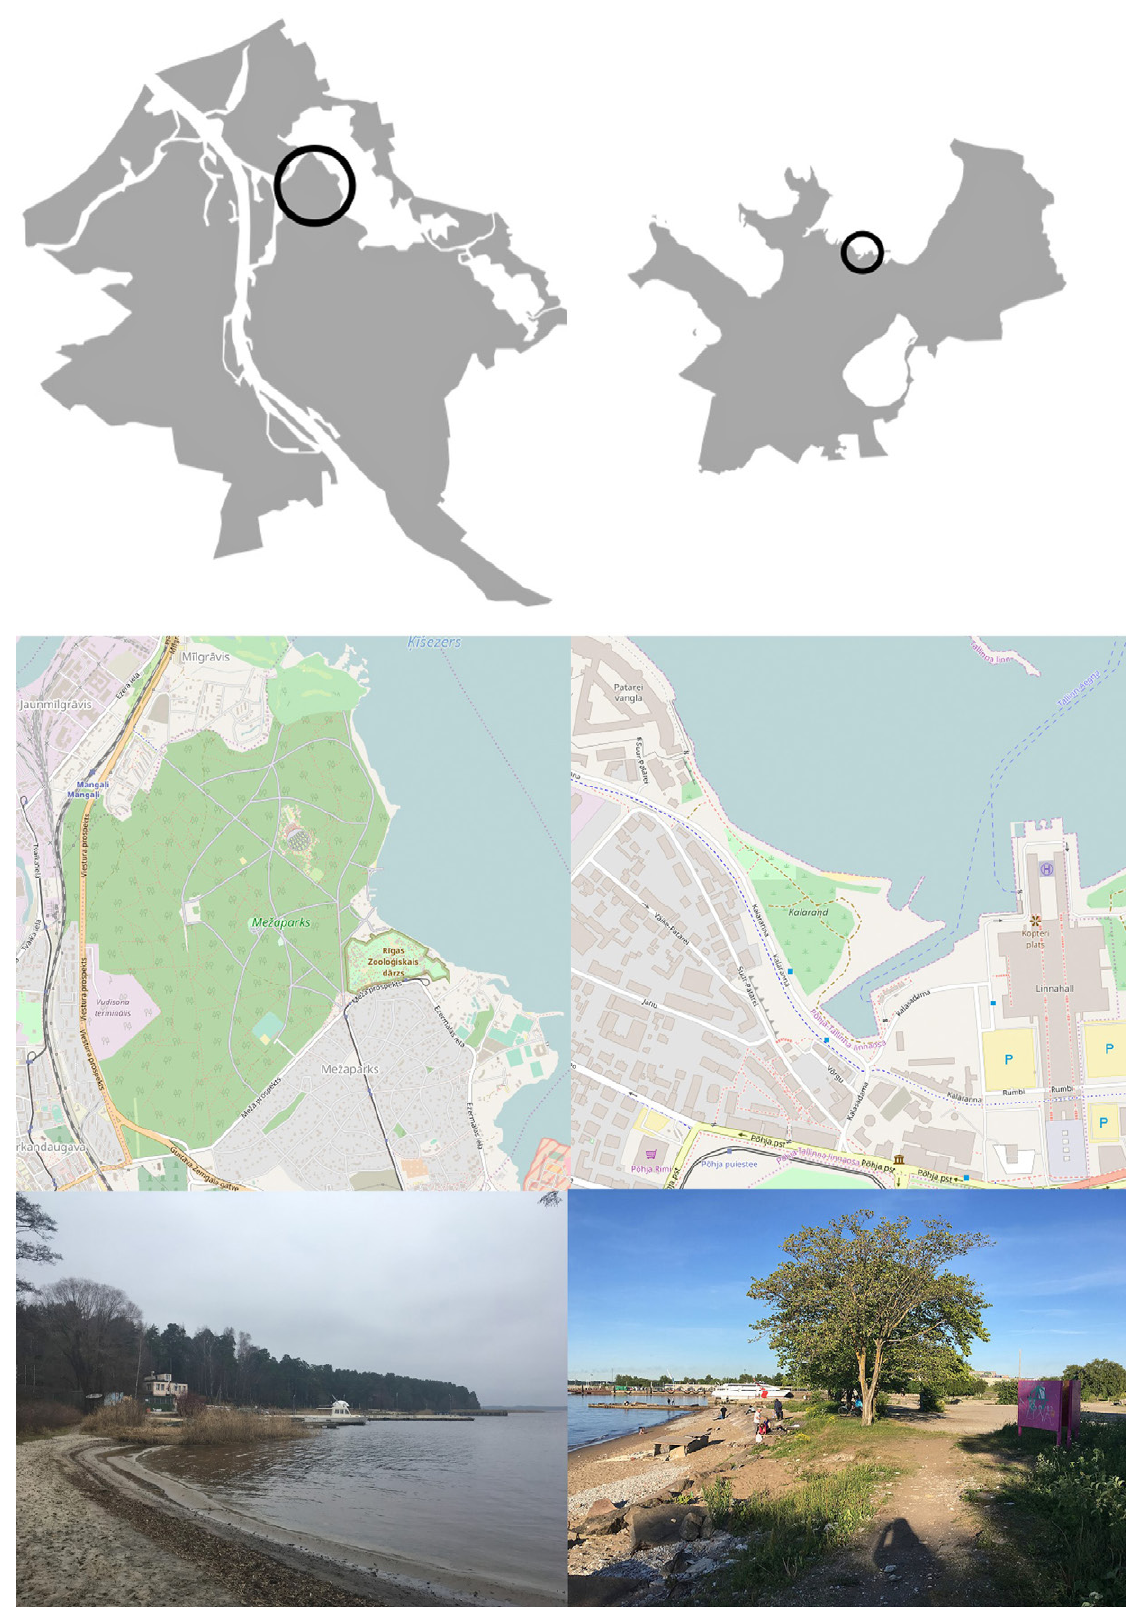
Figure 1. Top left: location of Mezapark in Riga; right: location of Kalarand in Tallinn (source: authors). Middle left: map of Mezapark; right: map of Kalarand (source: Open Street Map, 2017). Bottom left: Mezapark waterfront; right: Kalarand waterfront (source: